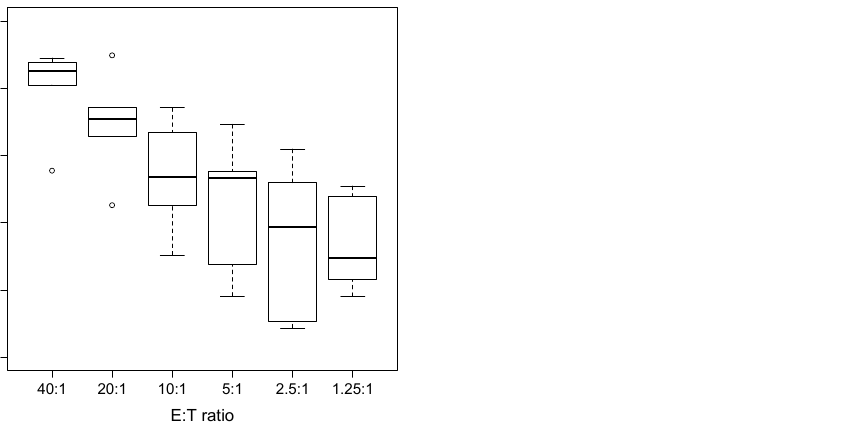
Figure 1. Chromium Release Assay. Chromium release assay (4 h) of IL2/IL15-NK challenged with HepG2 target cells labelled overnight with 5 µ Ci of radioactive 51Cr. The percentage of specific lysis was determined by measuring the amount of chromium released by dying cells in the supernatant, using the formula: lysis % = (mean experimental counts per minute (cpm) − mean spontaneous cpm)/(mean maximum cpm − mean spontaneous cpm) × 100%. Each boxplot describes the % lysis obtained with cells from five donors.